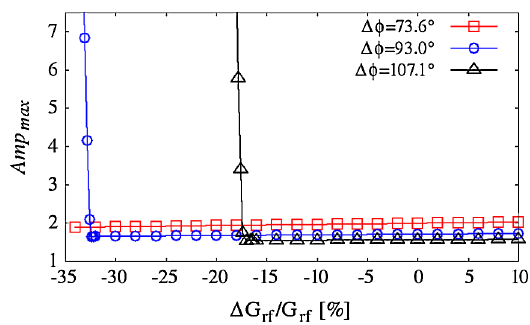
FIG. 10. Amplification of the beam in DBL1 for the FODO type of lattice with different phase advance per one